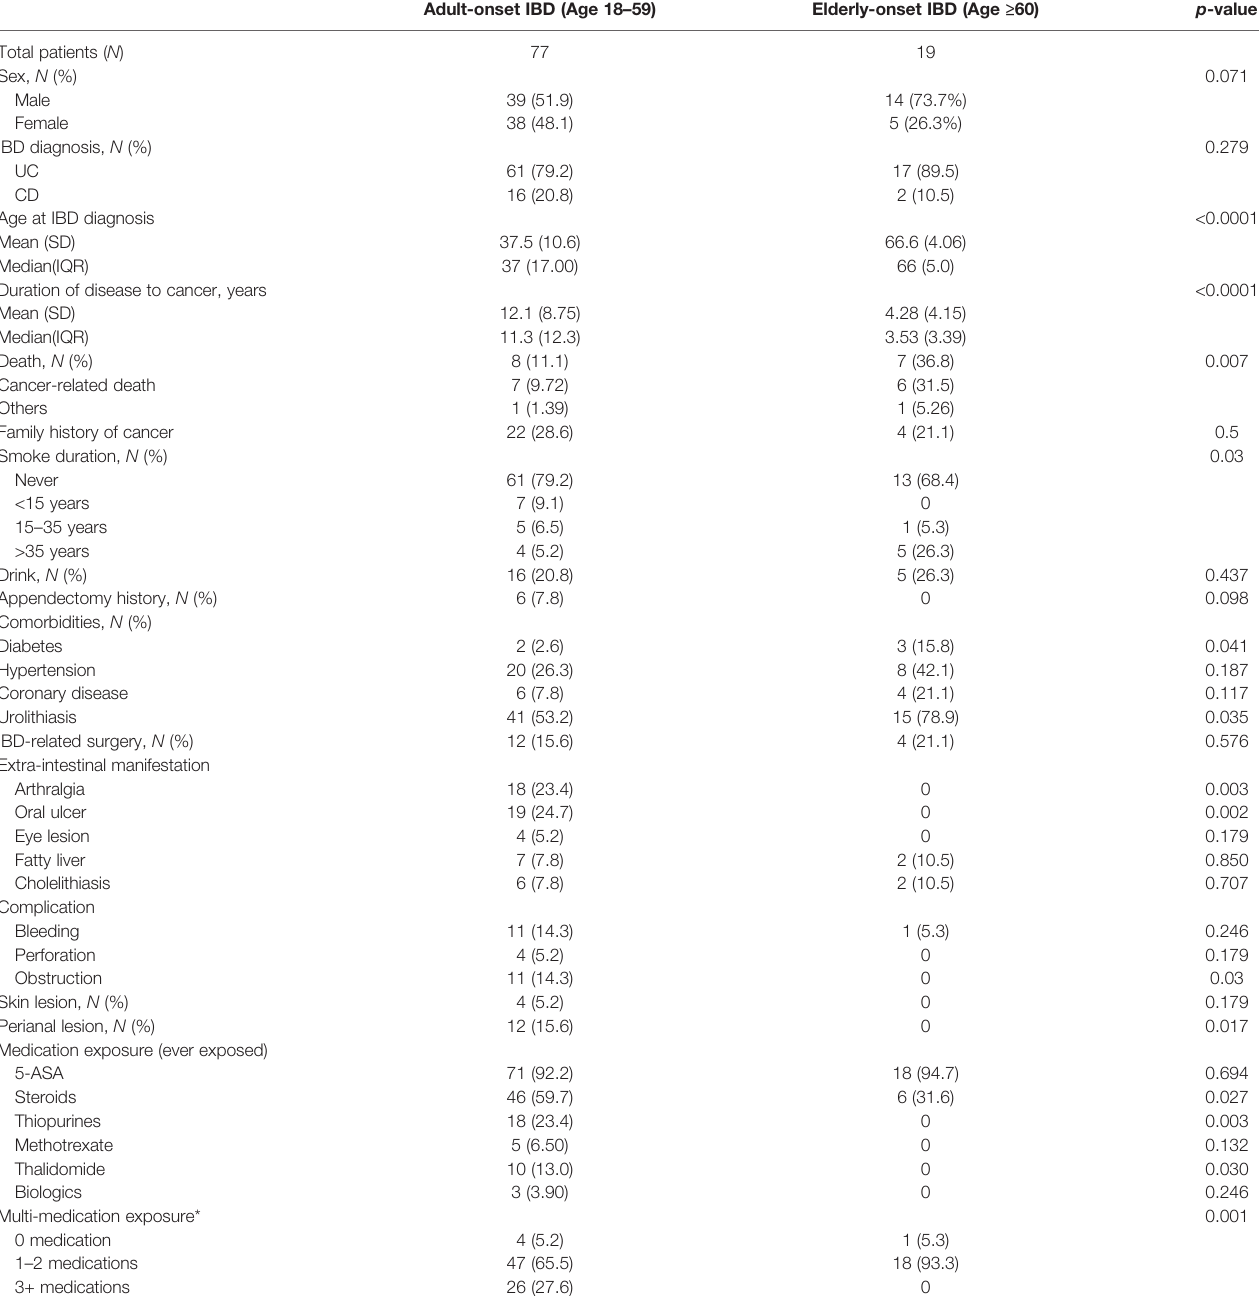
TABLE 3 | Patient characteristics of adult-onset and elderly-onset IBD patients who developed a